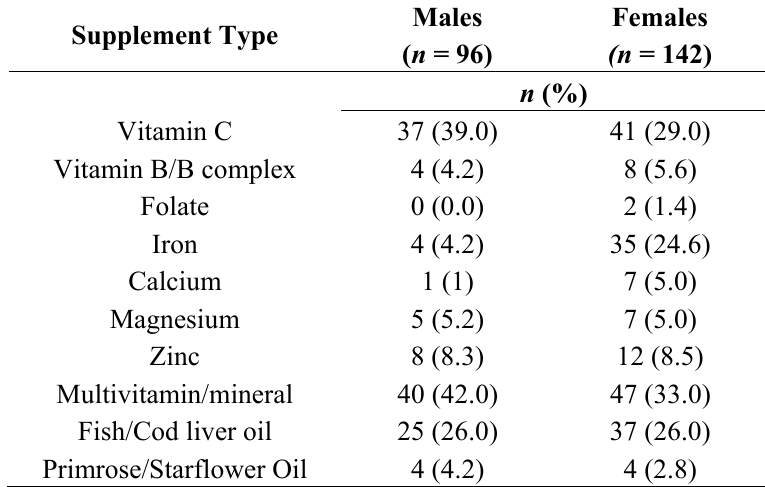
Table 2. Nutritional supplements consumed by 17 year old adolescents in the Western Australian Pregnancy Cohort (Raine)